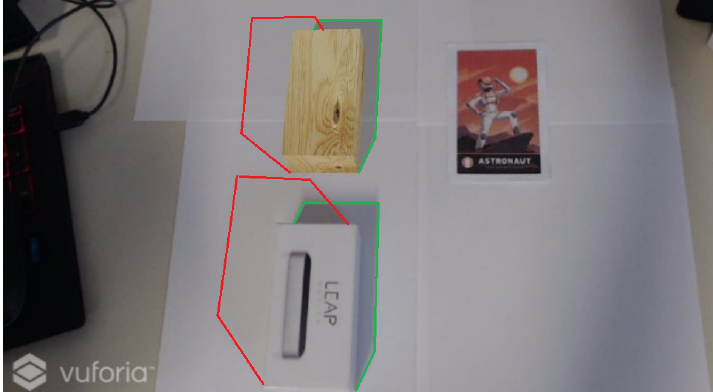
Figure 22. Highlighting of shadow direction and